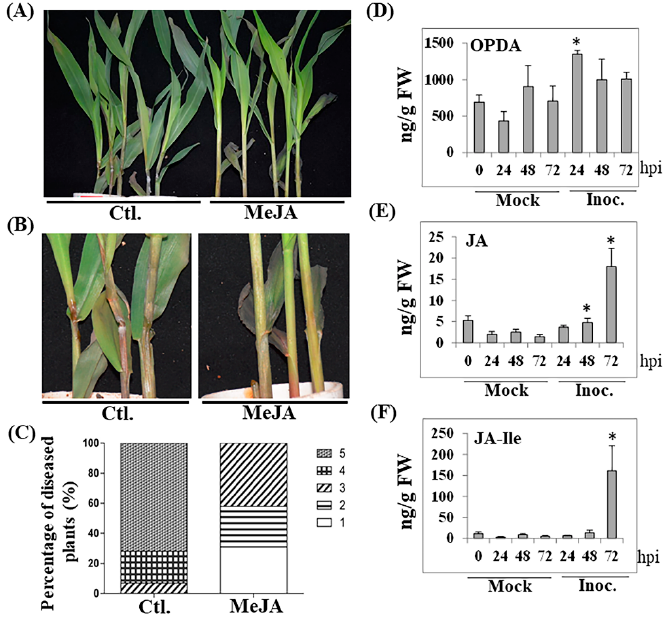
Figure 1. Exogenous MeJA enhanced disease resistance against F. graminearum . ( A ) GSR phenotype of whole seedlings of two-week-old B73 spayed with 100 µM of MeJA and that without MeJA treatment, followed by infection with F. graminearum . ( B ) the close-up of stems of partial Ctl.- and MeJA-treated seedlings shown in A. ( C ) the quantification of the percentage of diseased plants from A. The percentage of diseased plants was calculated based on the number of plants at each level over total plants. ( D – F ) endogenous contents of jasmonic acid and its analogs at different time points (hours post infection, hpi). Mock represents the treatment with H 2 O. The data are the mean of three replicates. * indicates the statistical significance ( p < 0.01) between mock and inoculation treatments at same time point analyzed by T-test.